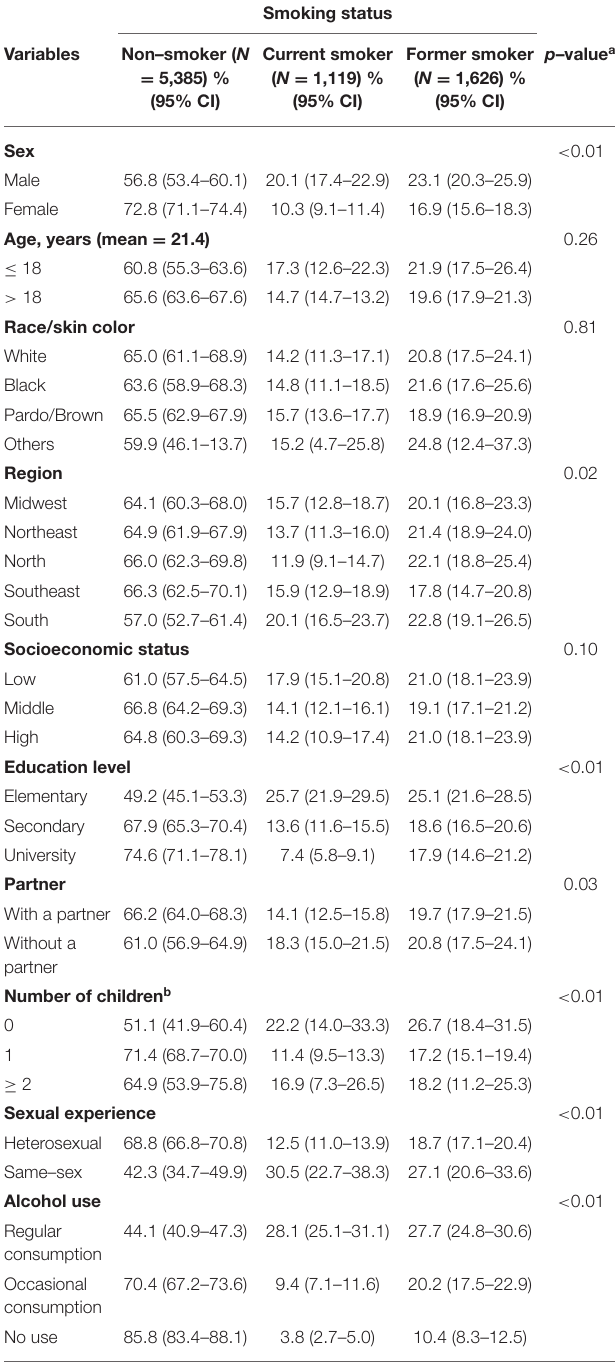
TABLE 2 | Smoking status according to sociodemographic and behavioral characteristics of the participants aged 16–25 years in Brazil, 2016–2017. Smoking